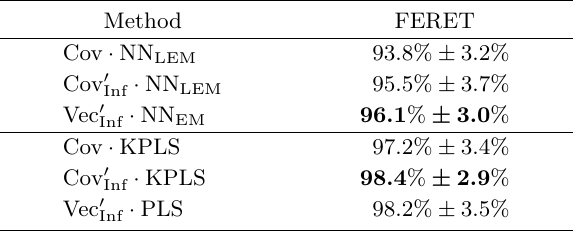
Table 3 Classification accuracies for the FERET